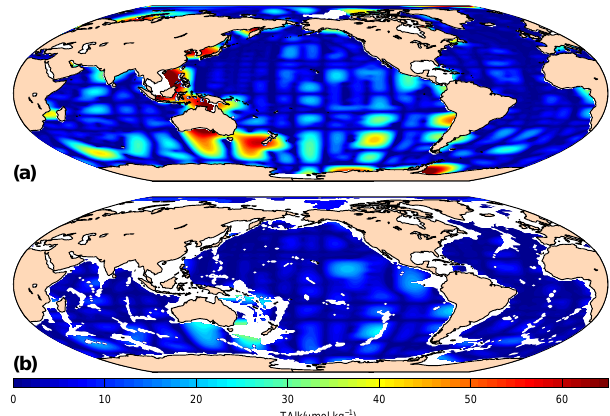
Figure 8. Difference between the gridded nitrate input data and the mapped climatologies at 10m (a) and 3000m (b) .